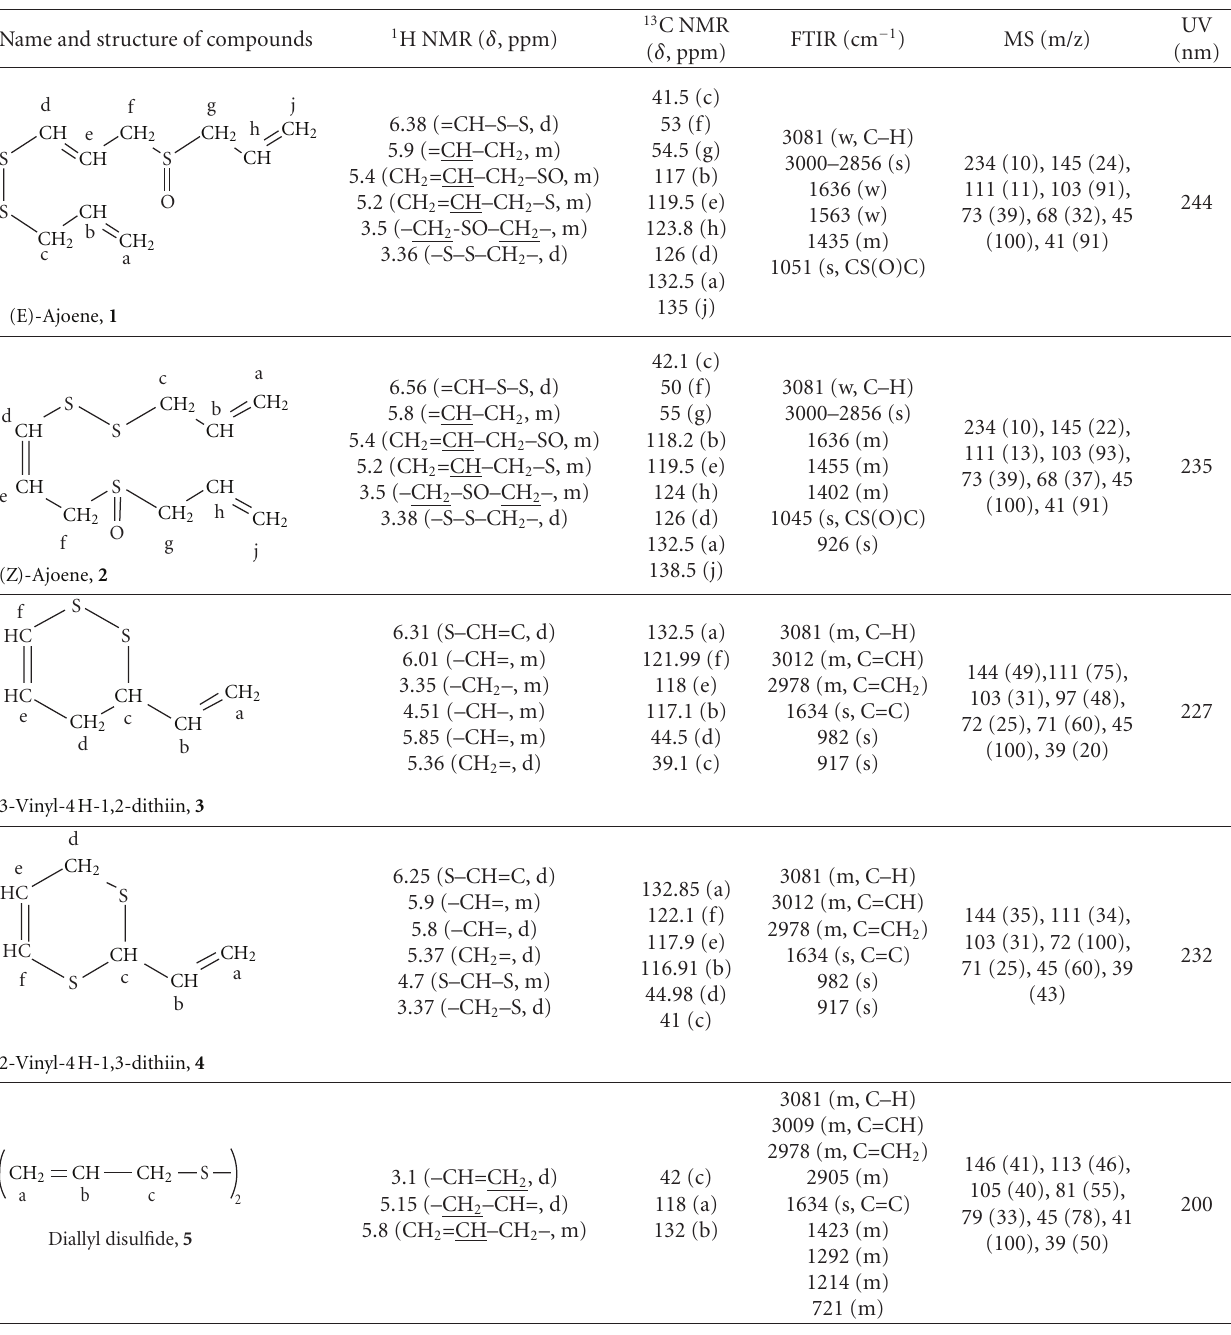
Table 1: Spectral data for the components isolated from the mixture of allicin transformation products obtained under the e ff ect of microwaves in methanol at 55 ◦